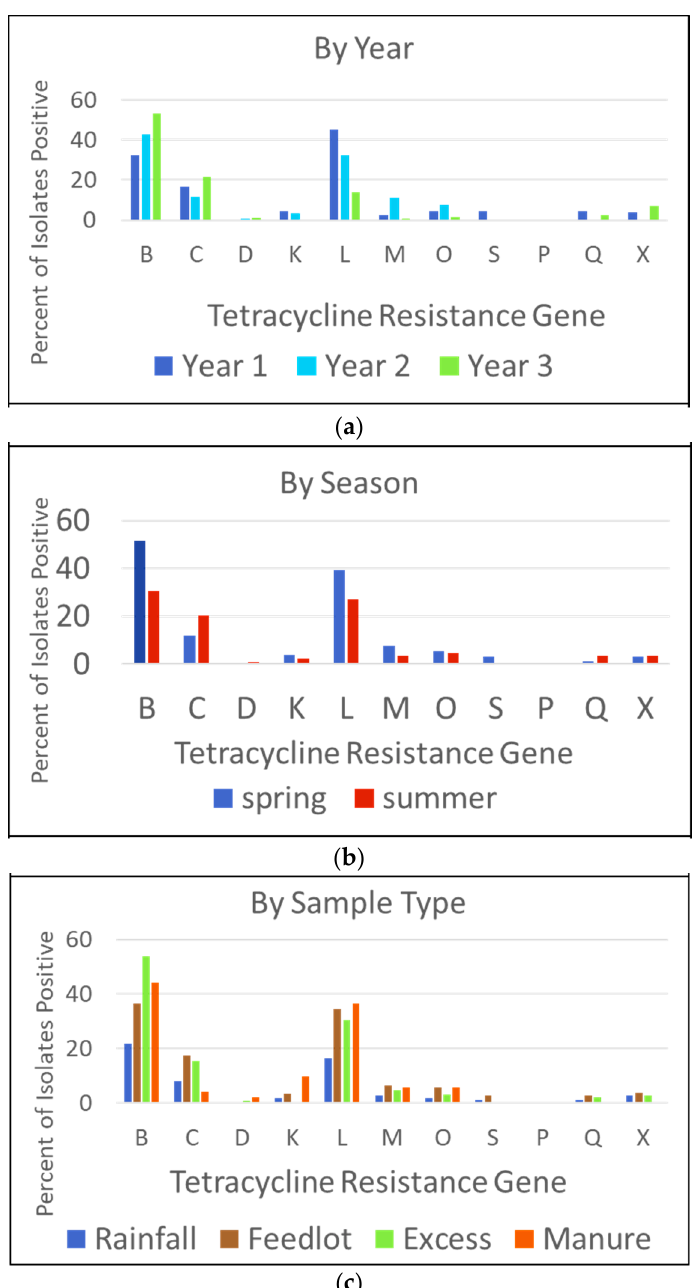
Figure 3. Prevalence of Tetracycline Resistance Genes. ( a ) By year ( n = 822 isolates). ( b ) By Season ( n = 822 isolates). ( c ) By sample type ( n = 822 wastewater isolates and n = 55 manure isolates). Note that x axis letters refer to tetracycline resistance genes.